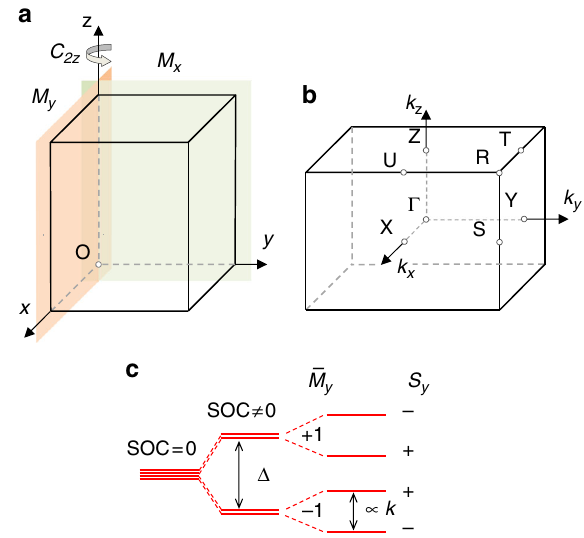
; ν ; η ¼ 0 ; 1 ( i = 1, 2, 3). i i i 2